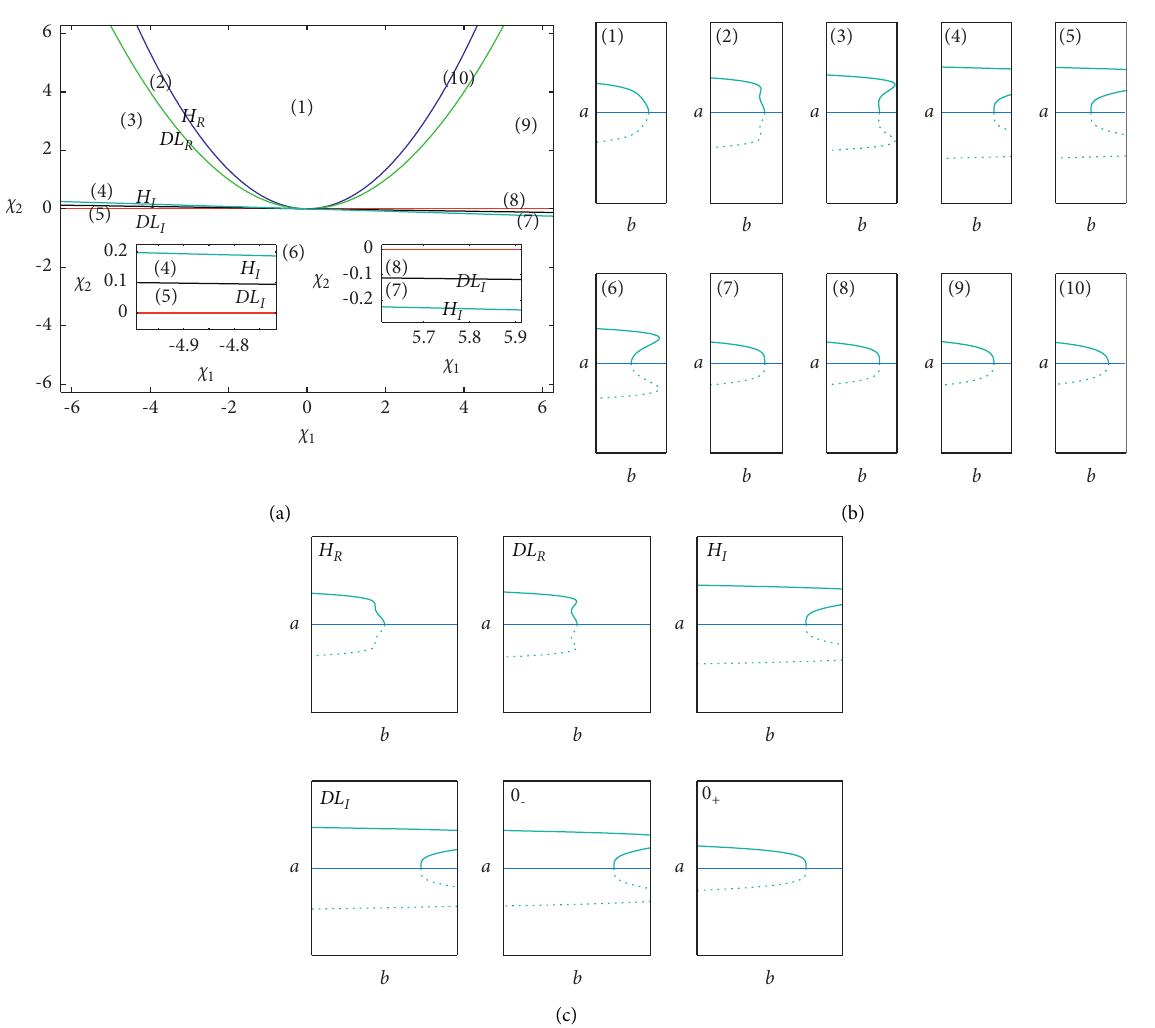
Figure 7: (a) Transition set and (b, c) bifurcation diagrams of the